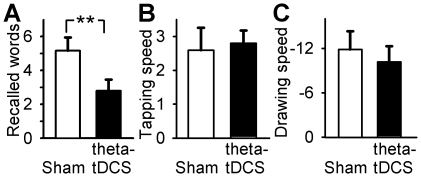
Theta-tDCS during NonREM sleep impairs declarative memory consolidation.(A) Retention performance on the declarative memory task (word paired-associates) across nocturnal sleep for the sham control and theta-tDCS conditions. Performance is expressed as difference between the number of correct words reported in a cued recall test at retrieval testing after sleep and in the end of learning before sleep. The list contained 46 word-pairs (**P<0.01). Performance across the retention interval on (B) the procedural finger sequence tapping task expressed as the difference in the number of correctly tapped sequences per 30 s between retrieval testing and learning, and on (C) the procedural mirror drawing task expressed as the corresponding difference in drawing time. Data are the means ± SEM. Times of performance testing within the experiments are depicted in Fig. 1.